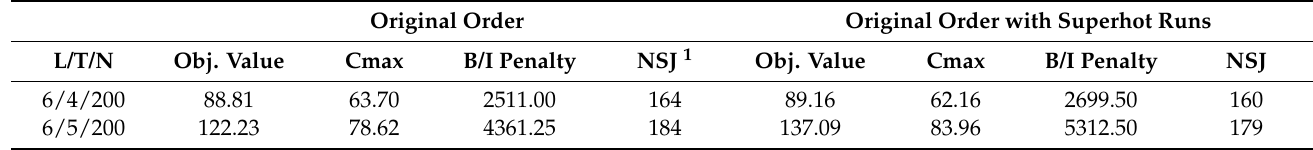
Table 6. The impact of superhot